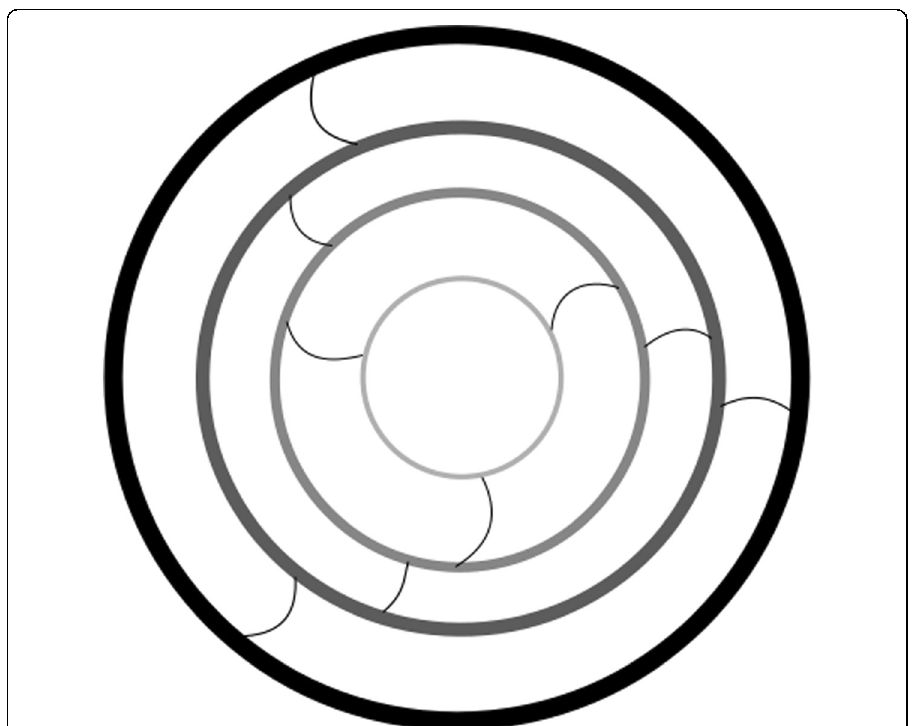
Fig. 10 Legend: The arrows indicate the increasing and decreasing movements of the webserver; smaller circles indicate the different sizes and speeds of